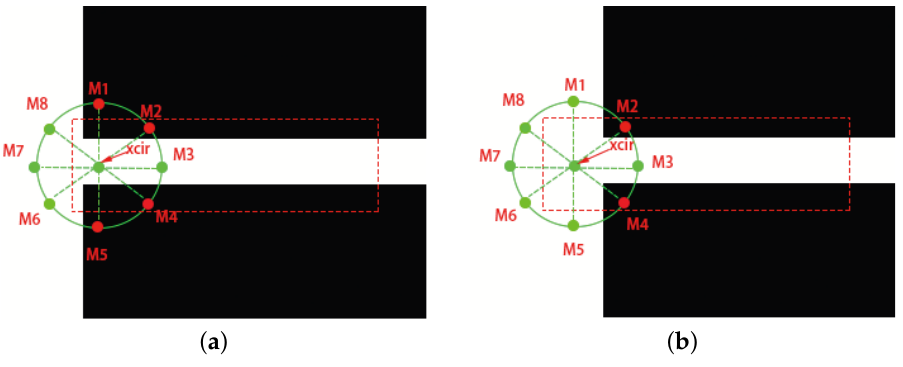
Figure 5. ( a , b ) are examples of x cir in the entrance of the narrow